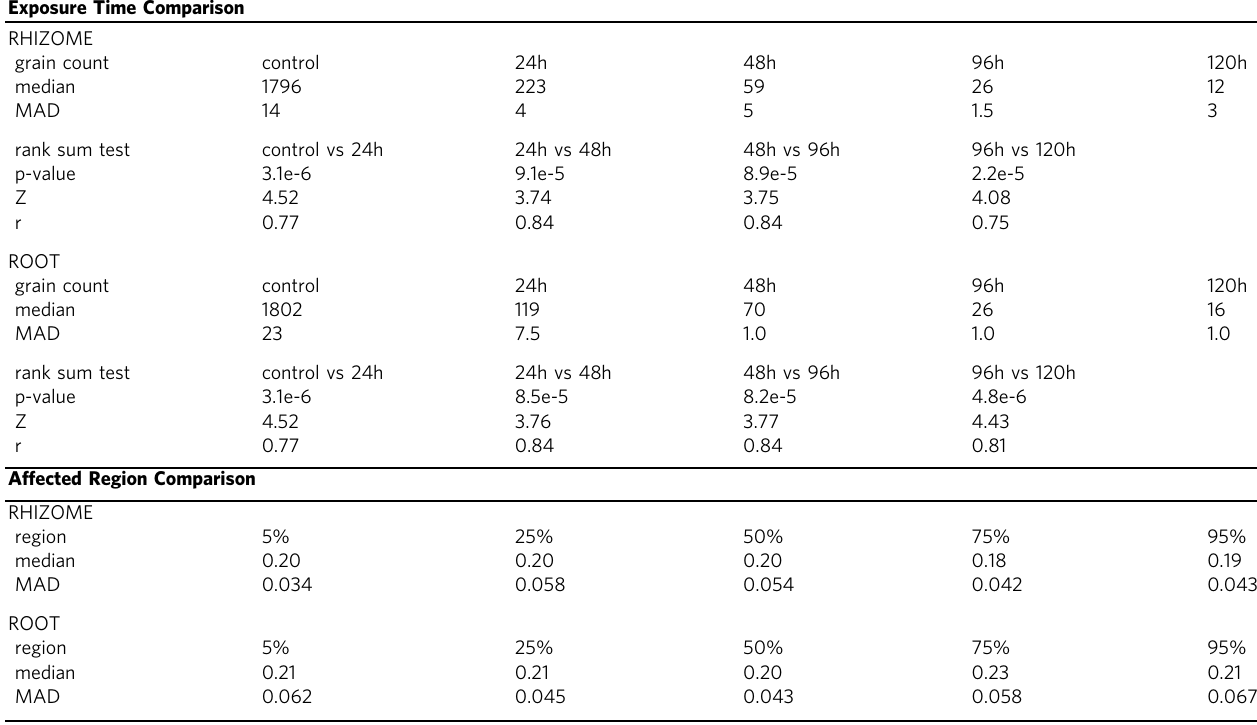
Table 1 . Median and median absolute deviation of grain counts with comparison test